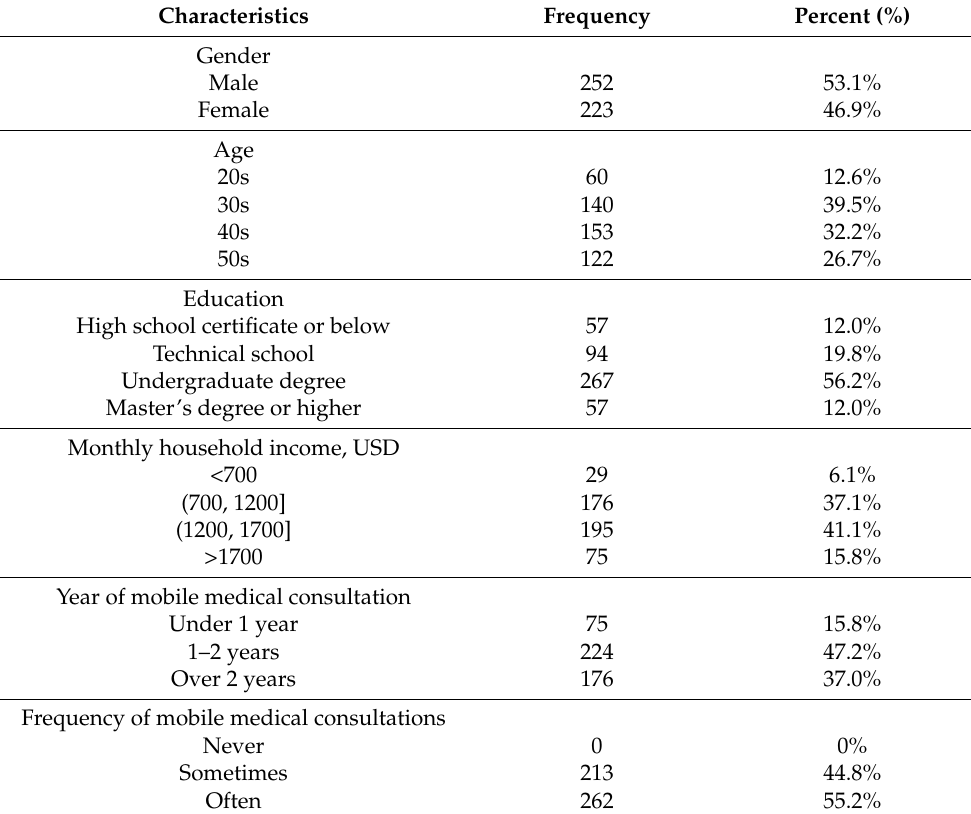
Table 2. Demographics of respondents ( n =